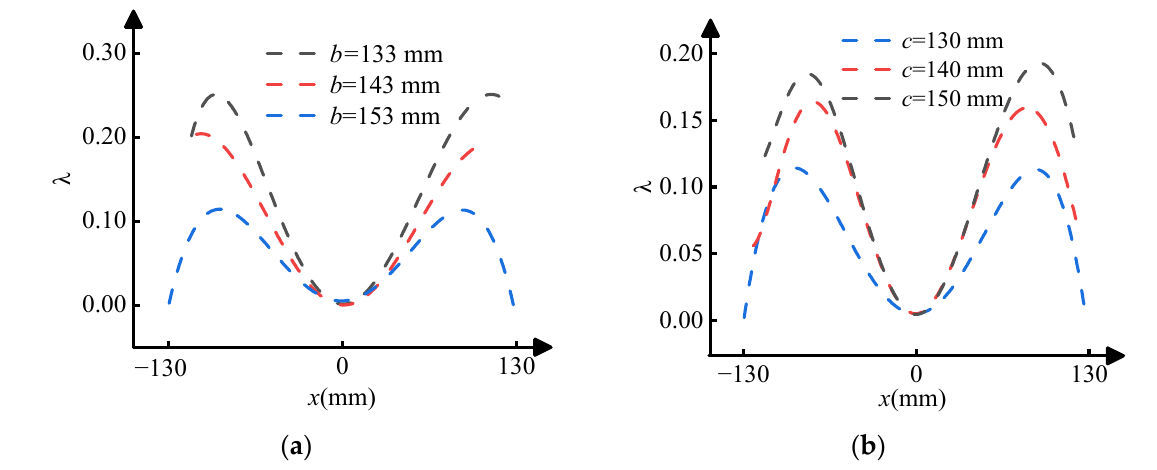
Figure 7. Magnetic induction intensity distribution varying with PI coil size: ( a ) When the outside diameter of PI coil changes; ( b ) When the inner diameter of PI coil changes.